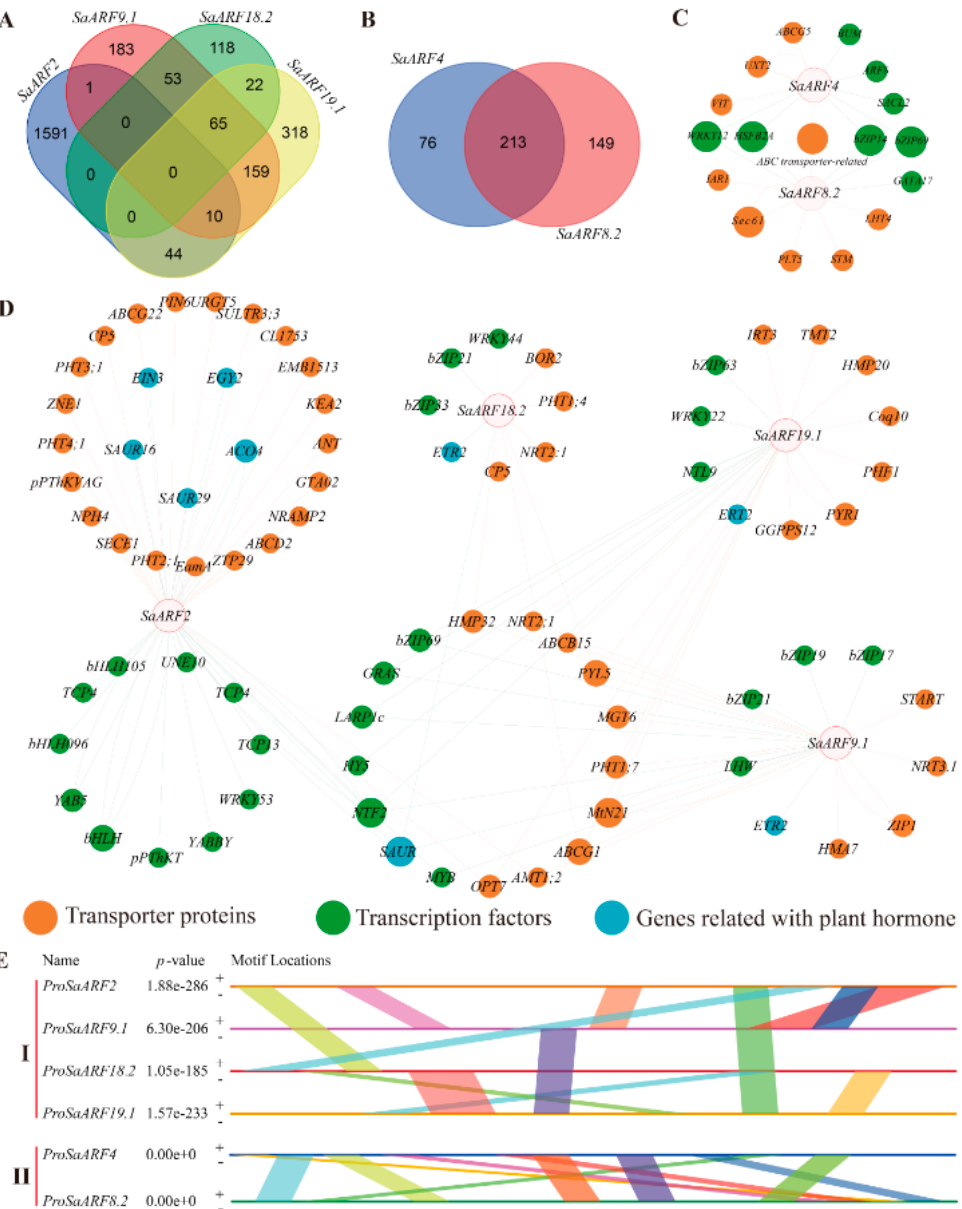
Figure 5. Similar segments of the hub-gene promoters and coexpression network analysis. ( A ) All related genes in the group of SaARF2 , 9 , 18.2 , and 19 . ( B ) The related genes in the group of SaARF4 and 8.2 . ( C , D ) showed the coexpression network containing the transcription factors, transporter proteins and genes related with plant hormone. ( E ) Similar segments in the promoters of hub genes. The same color in each group indicated a common similar segment.